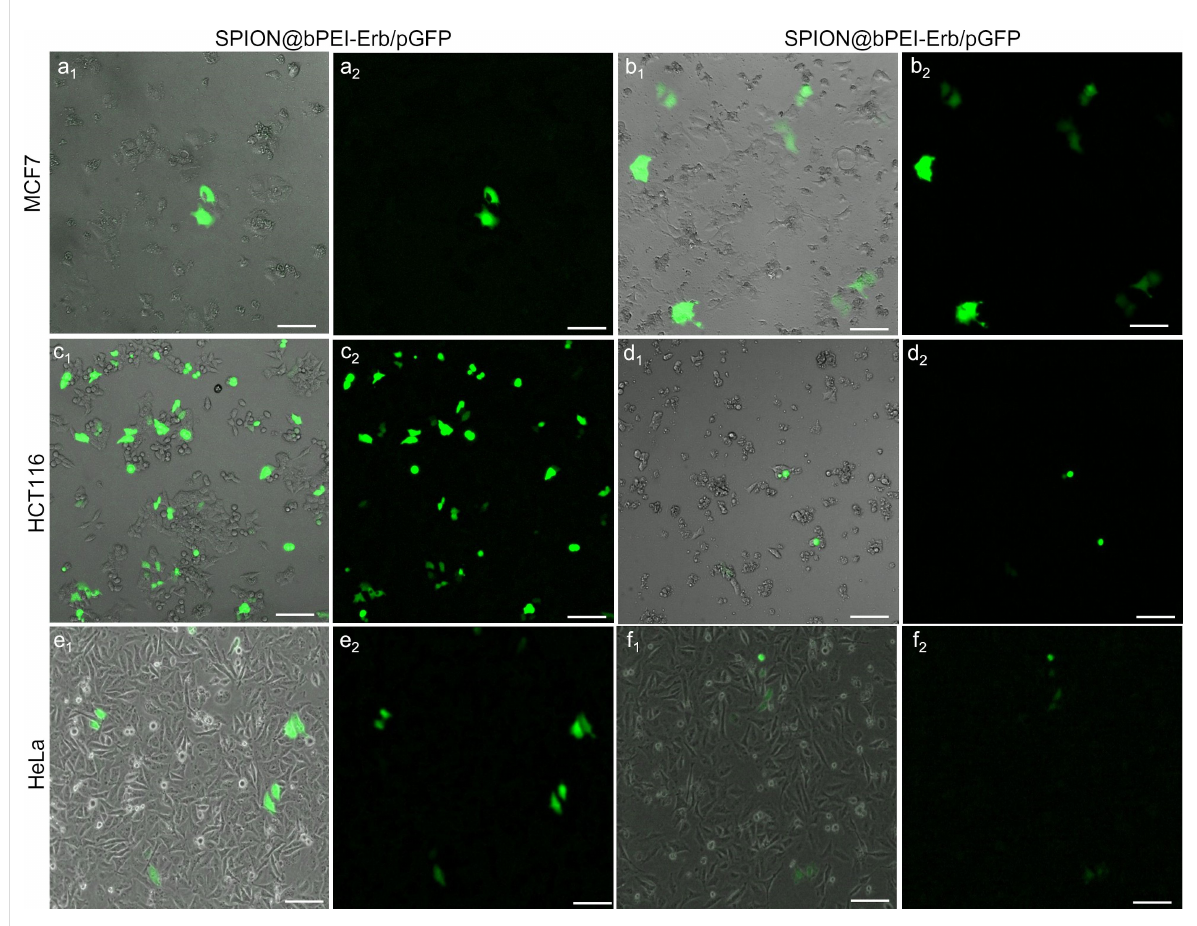
Figure 7: Fluorescence microscopy images of MCF7, HCT116, and HeLa cells transfected with SPION@bPEI-Erb/pGFP or SPION@bPEI/pGFP at N/P ratio of 45, 48 h after transfection: a-c-e: 1.2 µg/mL pDNA loaded on 20.7 µg/mL SPION@bPEI-Erb; b-d-f: 1.2 µg/mL of pDNA loaded on 19.2 µg/mL SPION@bPEI. Images with subscribed as 1 are the merged images, and images subscribed as 2 are green fluorescence microscopy images. Scale bar = 100 µm.